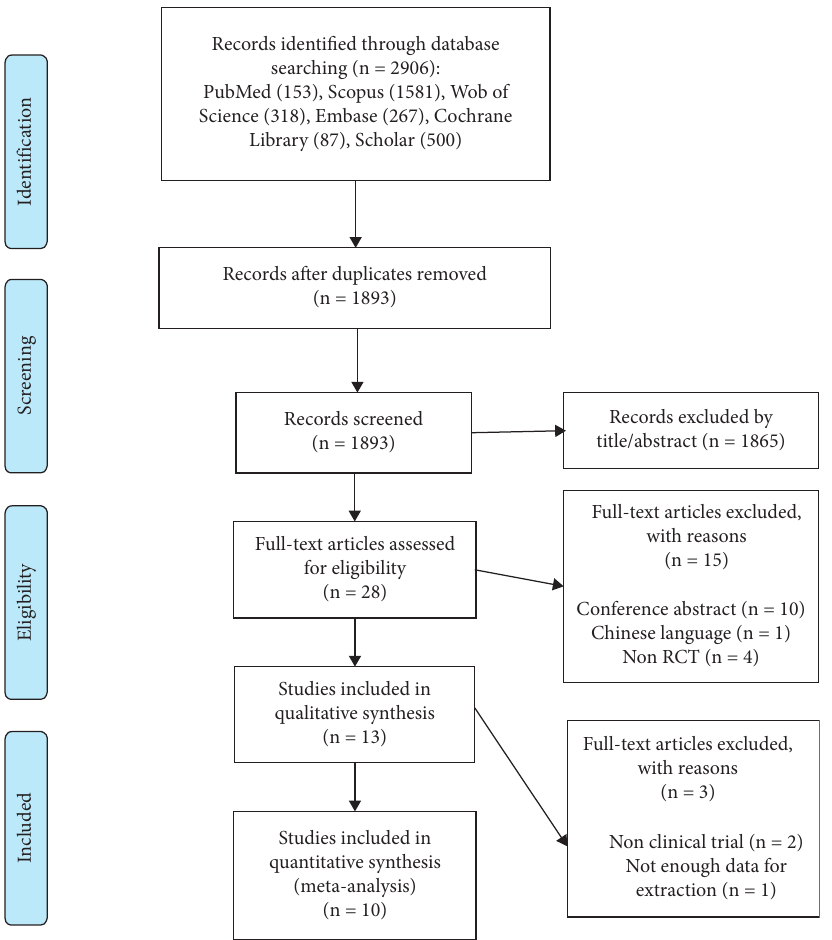
Figure 1: Flowchart of study selection